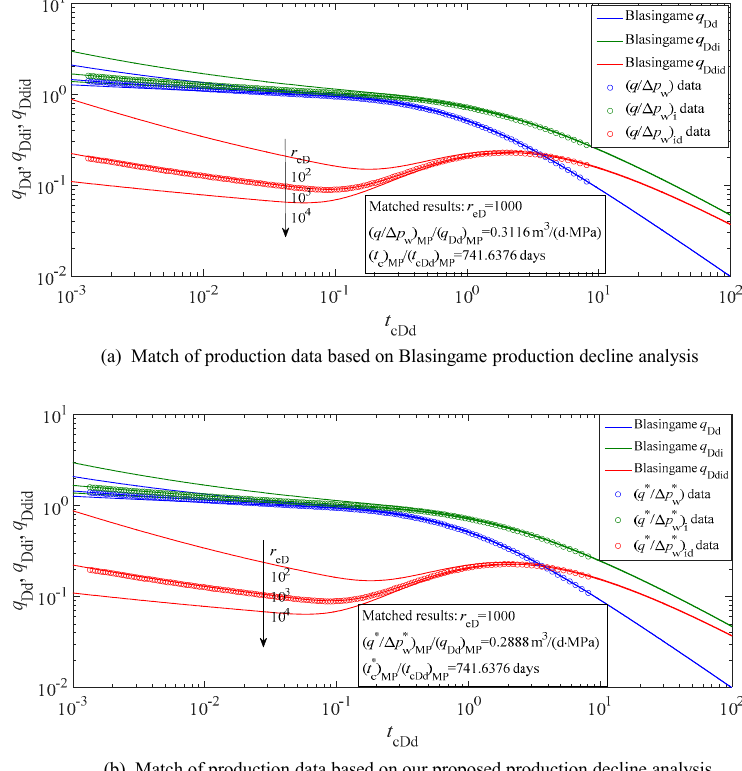
Energies 2019 , 12 , x FOR PEER REVIEW Figure 8. Match of production data for CPP case of Figure 8. Match of production data for CPP case of